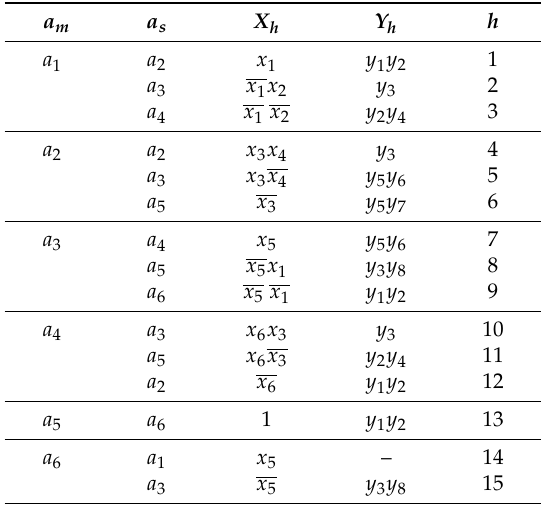
Table 2. STT of Mealy FSM S 1 .